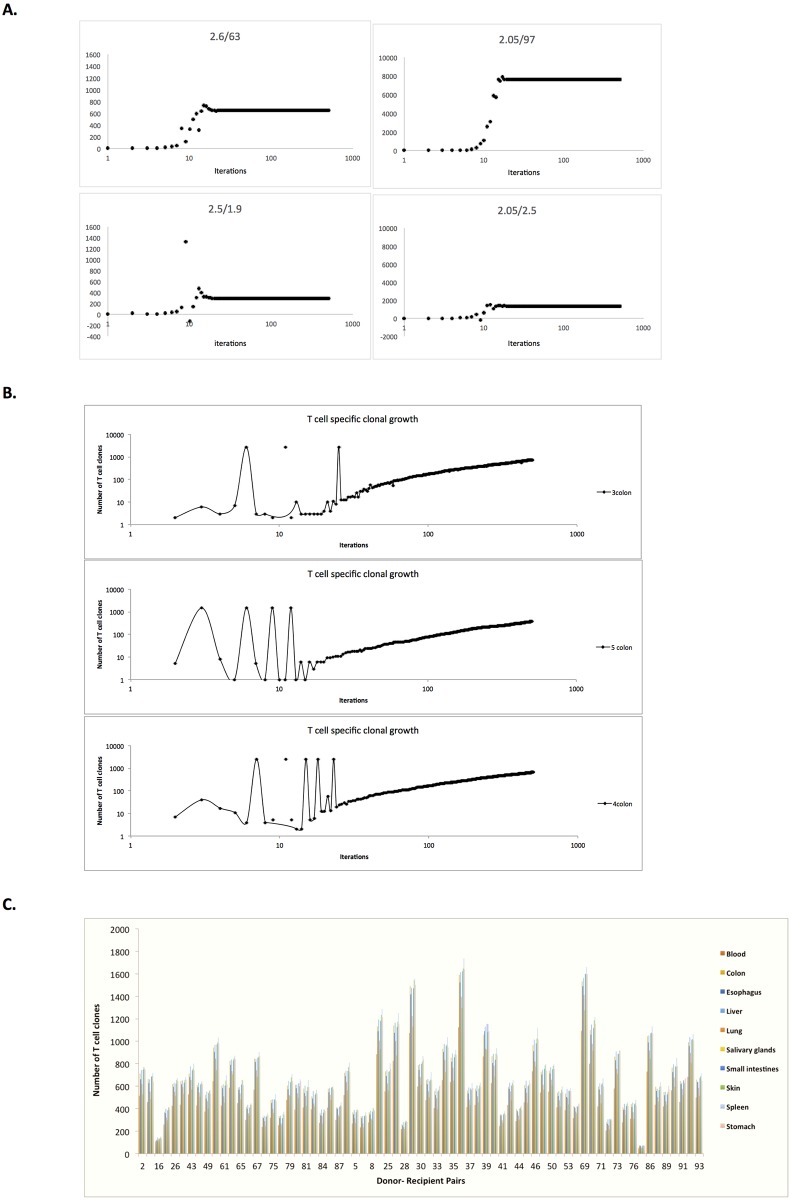
T cell clonal growth in SCT simulations.A. Individual T cell clone growth simulations accounting for peptide-HLA complex binding affinity and protein of origin tissue expression (IC50/RPKM). Increased T cell frequency (Y-axis) seen if the protein is expressed at a higher level. Different pmHA from a single patient/organ. B. Variable growth pattern of the number of clones in the simulations, number of clones rising over ‘time’ (iterations); T cell clonal growth in response to colonic alloreactive peptides depicted. C. Number of T cell clones after 500 iterations, reflecting the number of high affinity peptides expressed in the tissues studied (GTEX). A non-significant trend towards a larger number of clones in MUD recipients is observed in this graph.